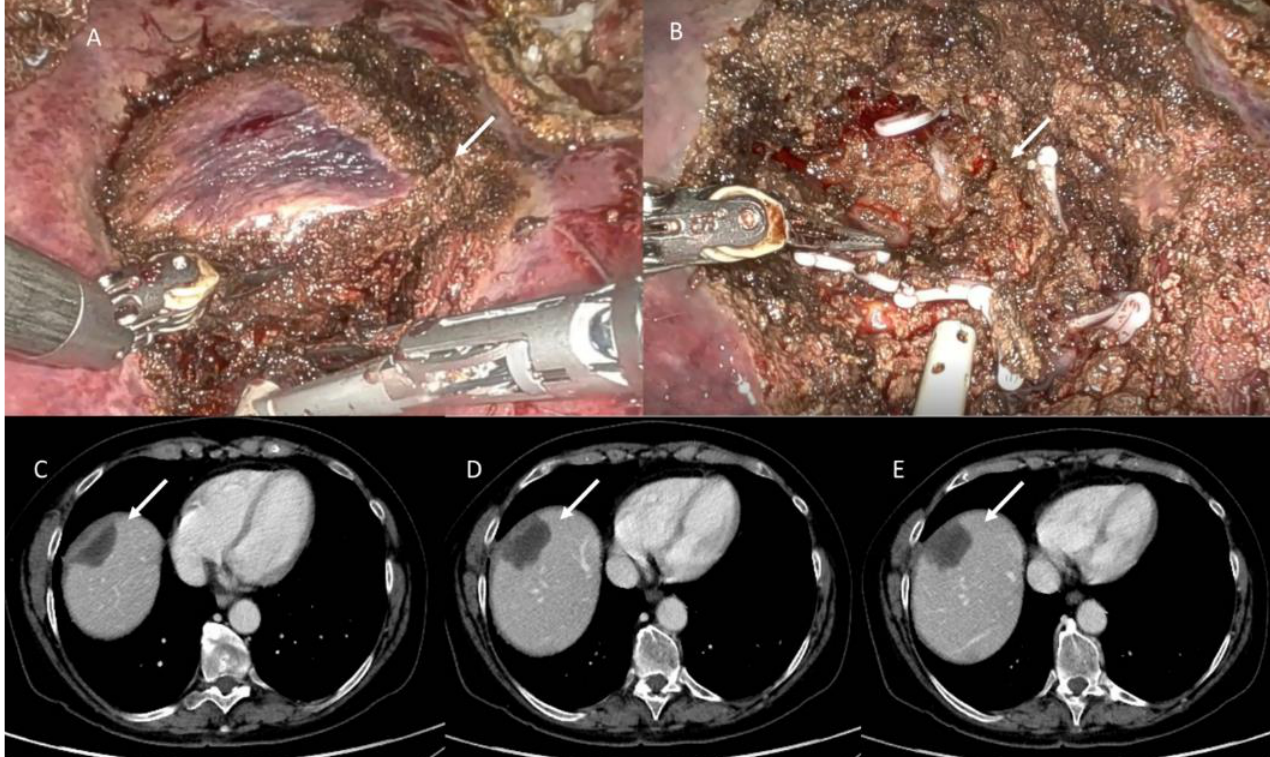
Figure 8. In ( A , B ) robotic atypical resection of lesion located in segment VIII. In ( C – E ), CT evaluation: arrows show fluid collection.